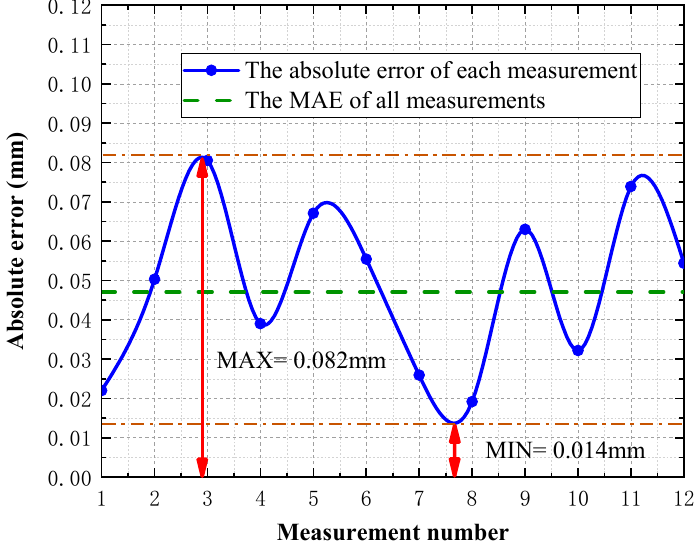
Figure 11. MAE of corrected spherical surface data diameter.